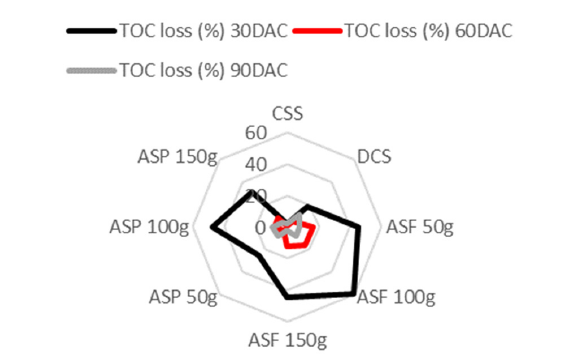
Figure 3. Percentage loss in total organic carbon (% TOC) of E. crassipes amended diesel contaminated soil CSS = Control Soil, DCS = Diesel oil Contaminated Soil, ASF = Amended Soil with Fresh E. crassipes , ASP = Amended Soil with Powdered E. crassipes, DAC= Days After